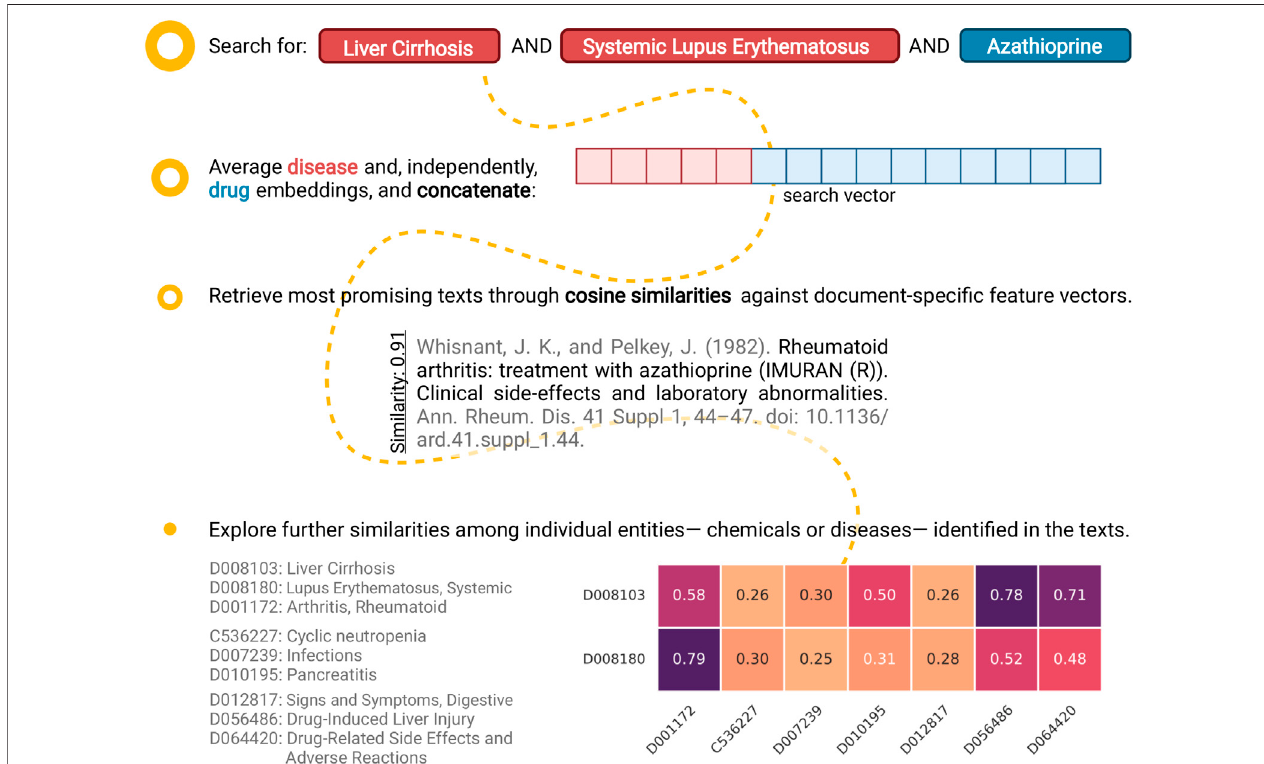
FIGURE 7 | An example case of exploratory analysis: retrieving non-trivially similar papers. Identifying documents that co-mention “ Liver Cirrhosis (LC), ” “ Systemic Lupus Erythematosus (SLE), ” and “ Azathioprine ” presents an interesting challenge, as that speci fi c combination does not exist in the positive training set. Notably, searching through the complete (positive and negative) training set using our proposed approach uncovers a non-trivially similar text as the best hit (cosine similarity of about 0.91).Further lookingintothesimilaritiesbetweenthequeryand in-text diseases(along the x -axis; sortedbydecreasingin-text frequency) revealsthat,while no overlapping terms exist, a link between SLE and rheumatoid arthritis has been identi fi ed (similarity of 0.79). Likewise, the close connection between LC, and Drug- Induced Liver Injury (DILI) and adverse drug reactions has been captured (similarities of 0.78 and 0.71, respectively) (Created with BioRender.com).